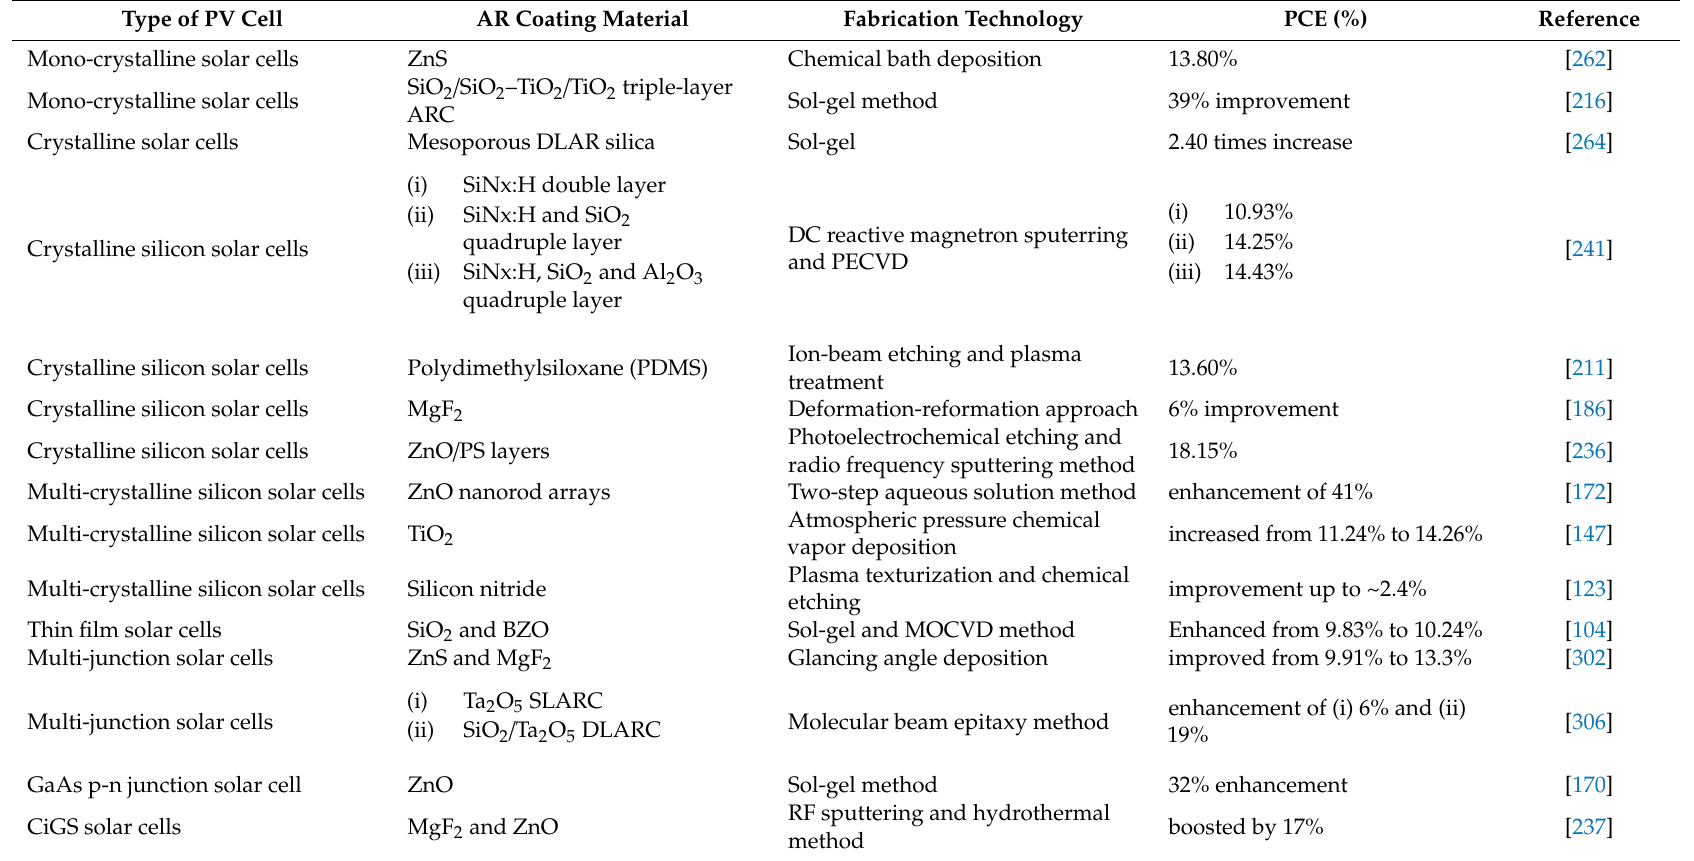
Table 7. Antireflection coatings on PV